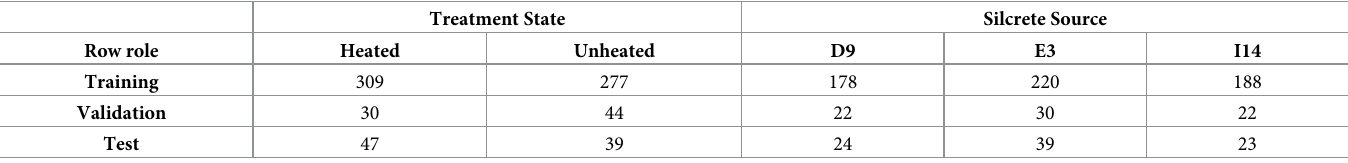
Table 4. k-NN model B observation roles for training, validation, and